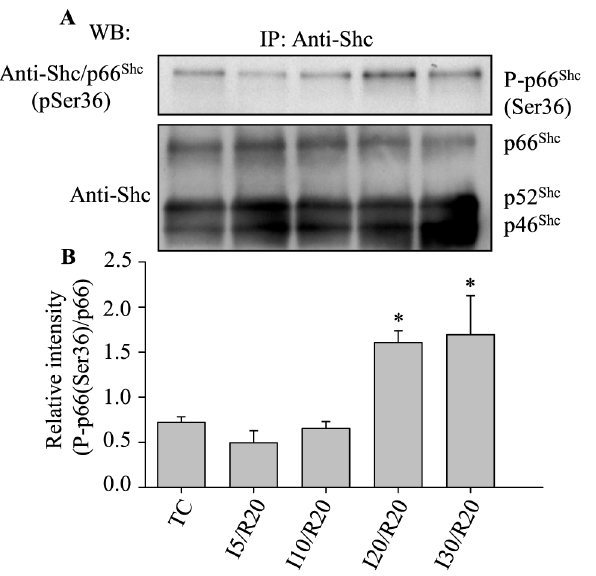
Figure 3. Phosphorylation of p66 Shc at Ser36 during reperfusion after ischemia was dependent on the duration of ischemia. A , upper panel: phosphorylation of p66 Shc at Ser36; A , lower panel: total p66 Shc level for loading control. B : Summary of mean band intensities derived from three independent experiments (n 5 3 hearts/group) (see Fig. 1 for imaging). P , 0.05: *I20 and I30 vs. I5, I10 and TC.